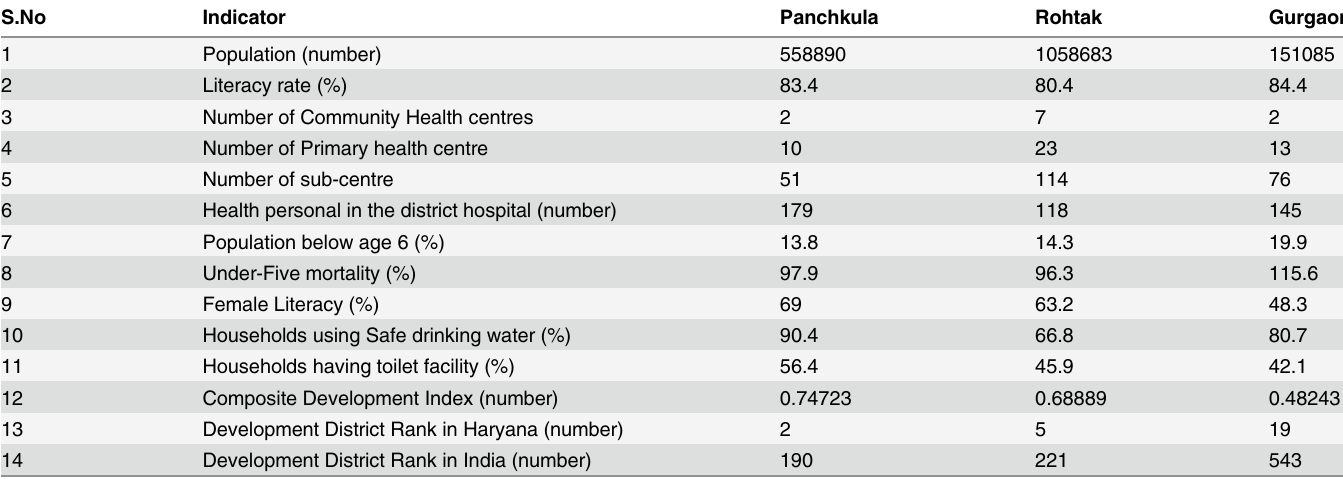
Table 1. Profile of Study Districts Based on Socio-economic and Demographic